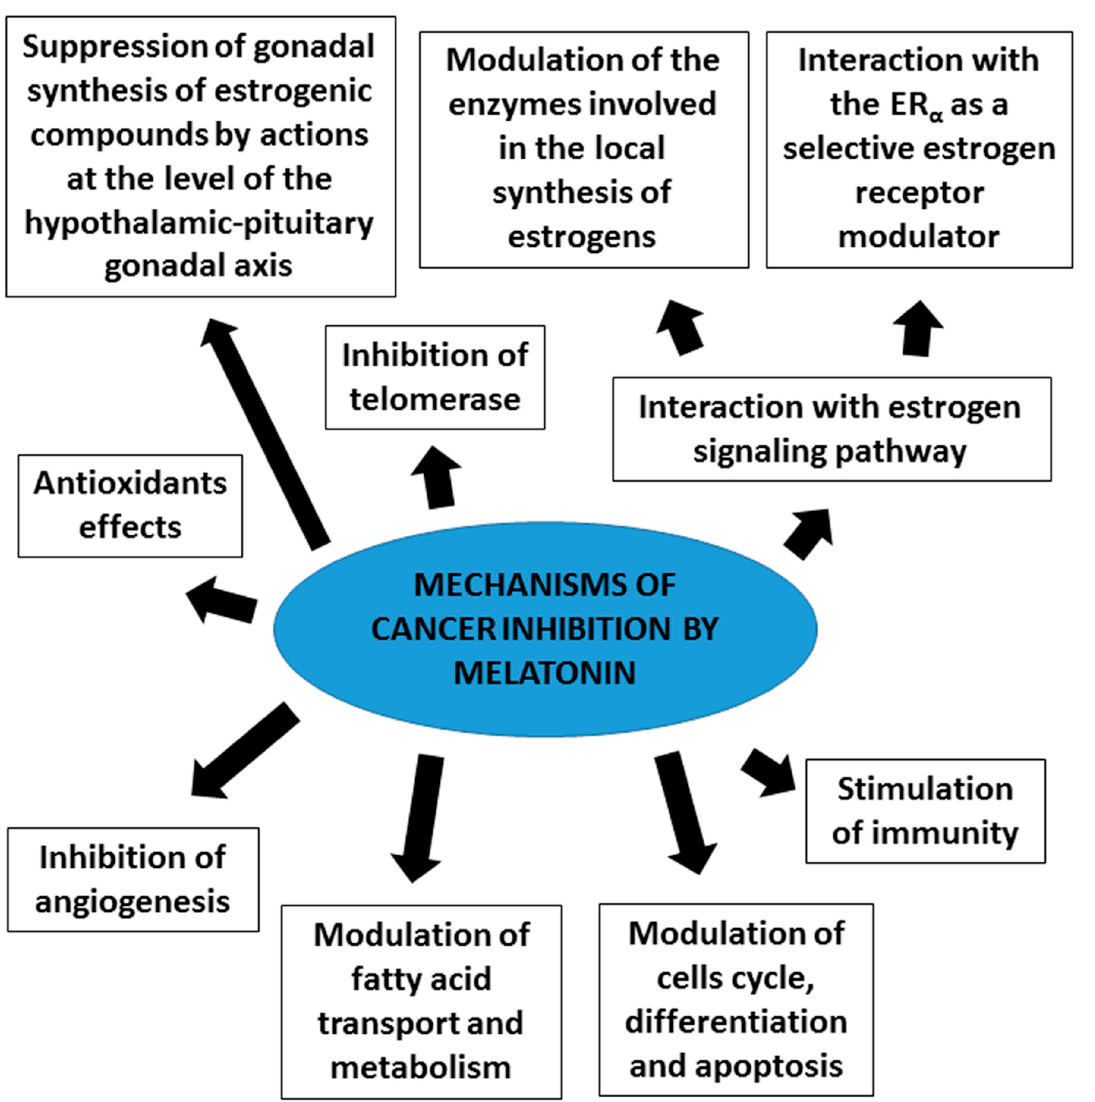
Figure 1. Mechanisms involved in melatonin antitumor actions.